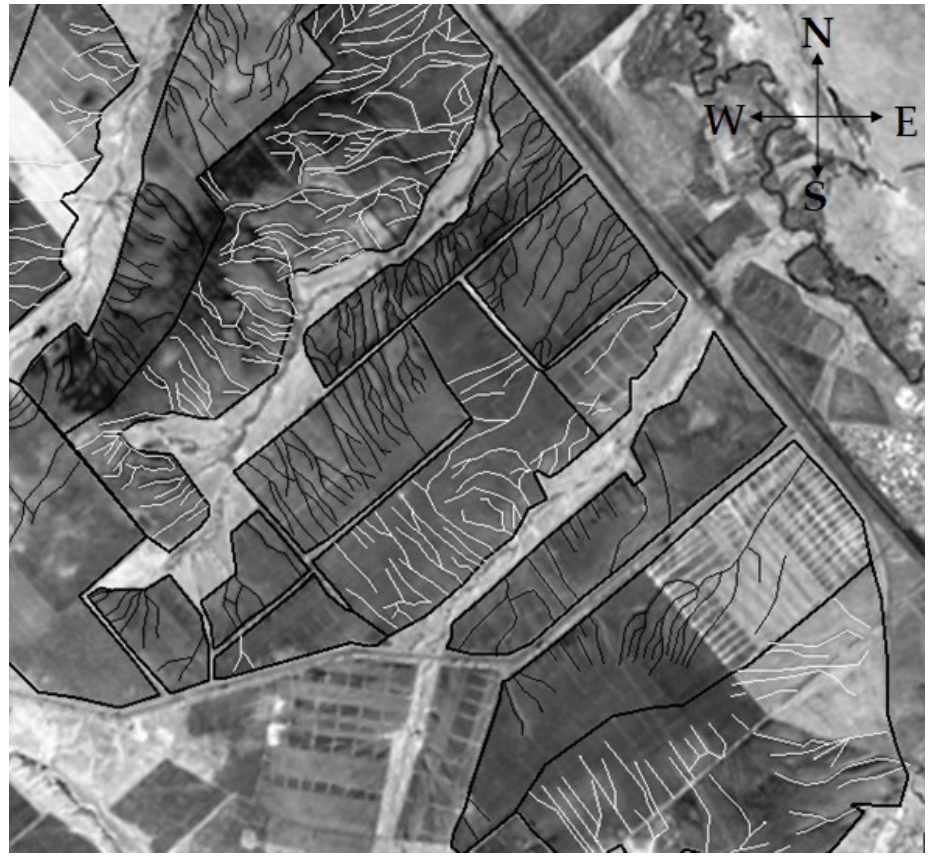
Figure 7. The distribution of areas by exposure of slopes in the Samara river basin (scale 1:80,000).